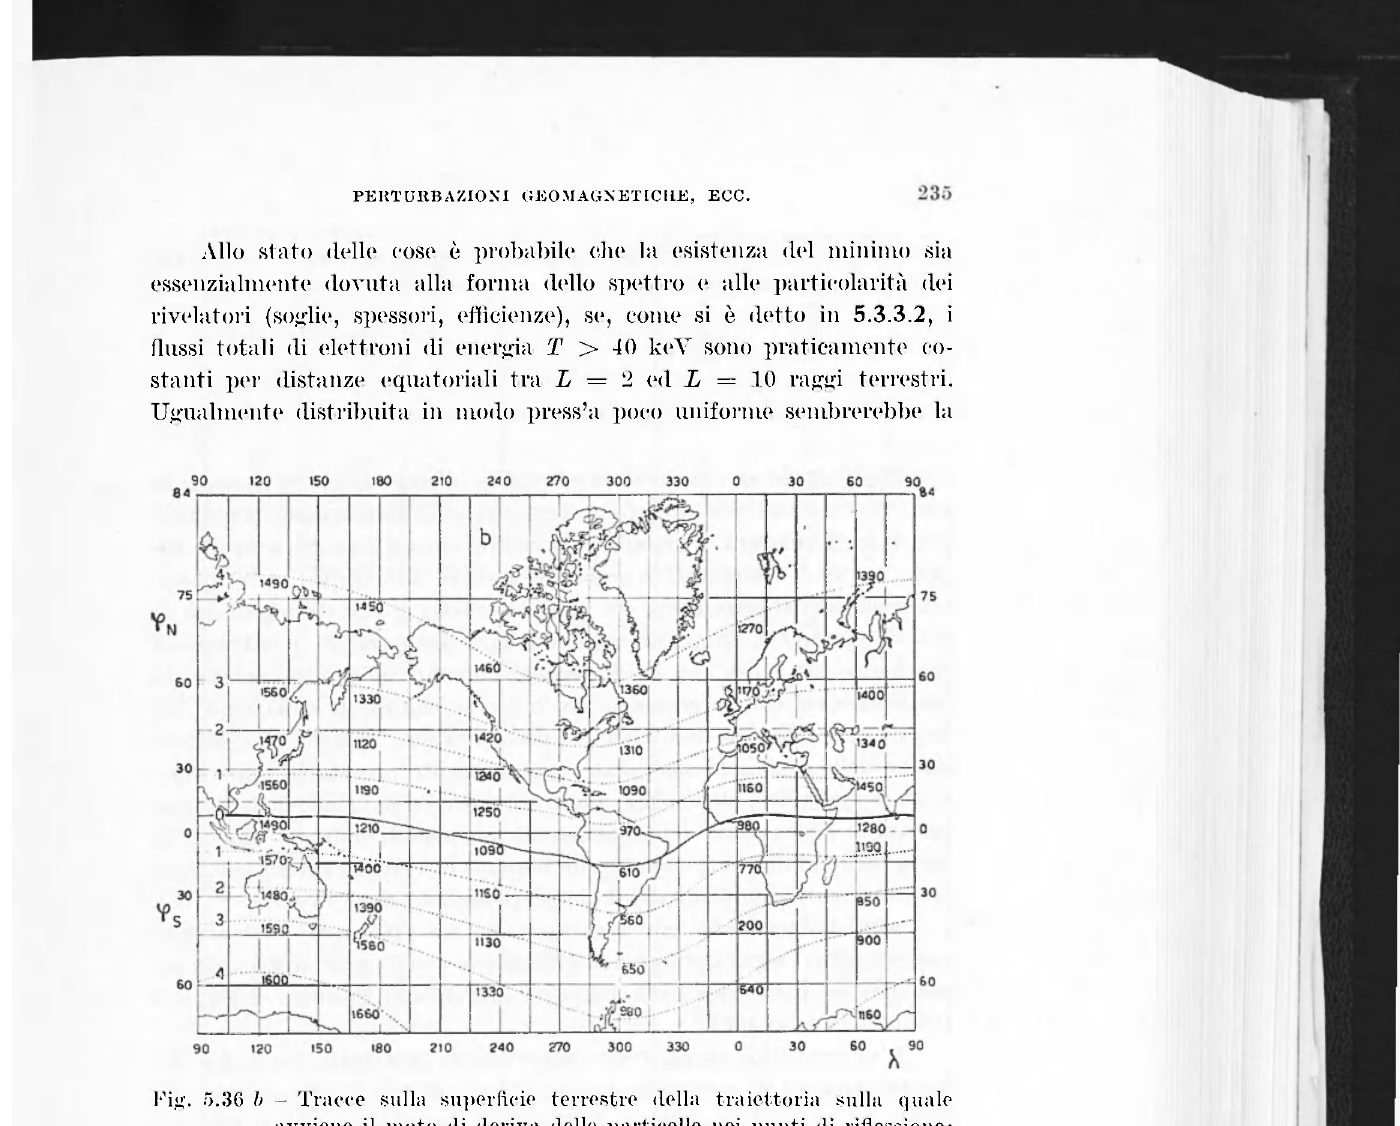
Fig. 5.36 b - Tracce sulla superficie terrestre della traiettoria sulla quale avviene il moto di deriva delle particelle nei punti di riflessione; si riportano le altezze sul suolo (in km) a intervalli di 60° di longitudine; le curve indicate con le coppie di numeri 1, 2, 3, 4 rappresentano le tracce per punti di riflessione coniugati; la curva indicata con 0 rappresenta la traiettoria per particelle aventi angolo di inclinazione costante uguale a 90° (secondo Cladis e